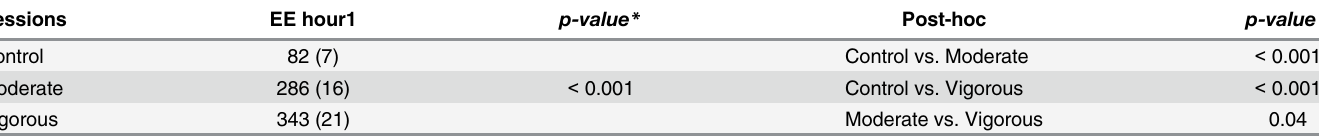
Table 2. Energy expenditure (EE, kcal) in physical activity in the first hour of registration.